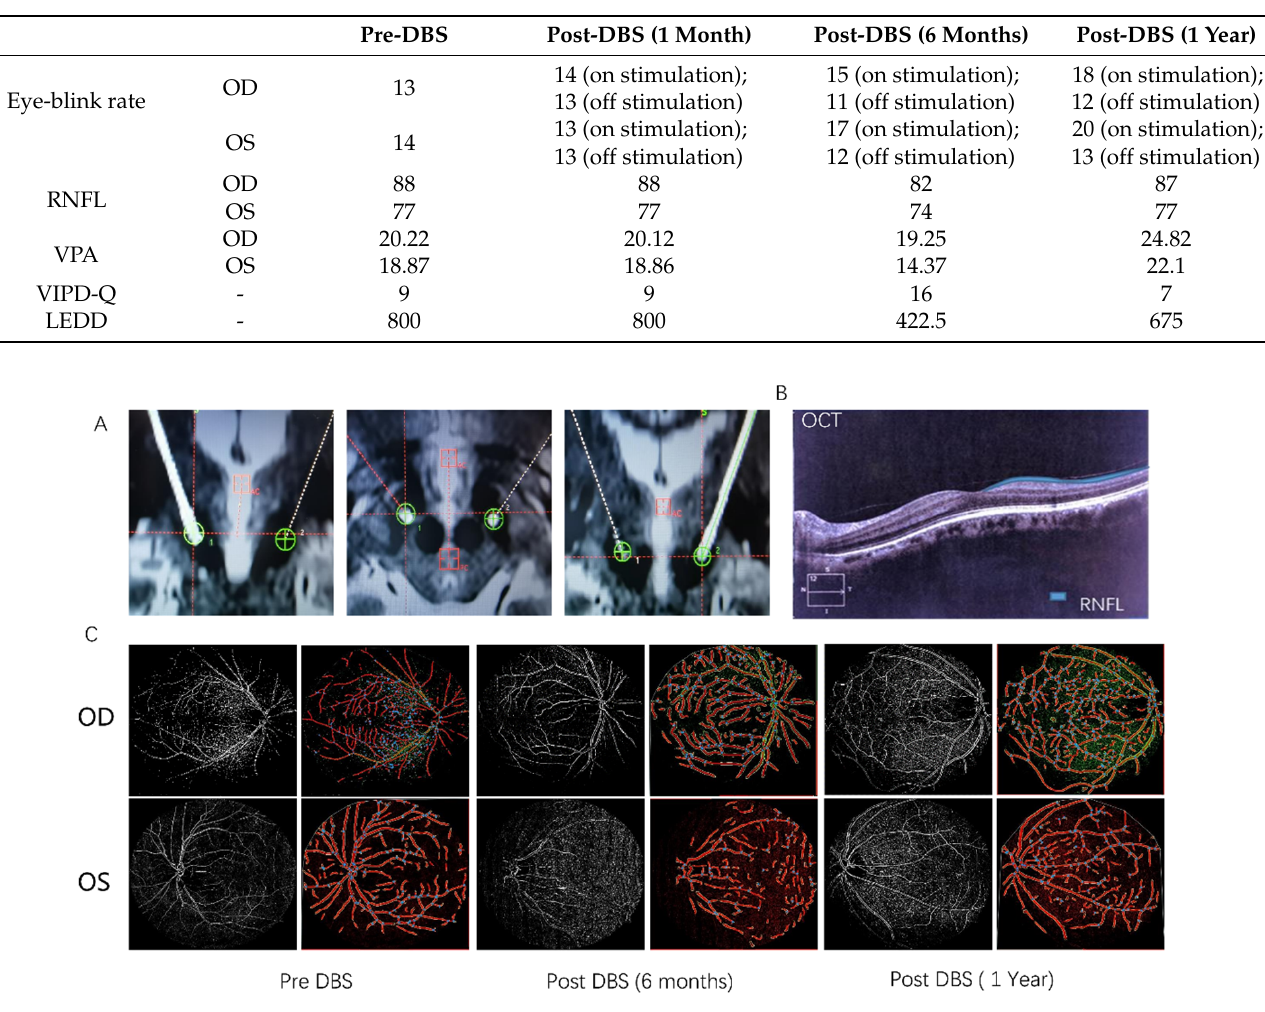
Figure 1. ( A ) The DBS contact locations. ( B ) The thickness of the patient’s retinal nerve fiber layer (RNFL) measured by OCT. ( C ) The vessel percentage areas of the patient before and after subthalamic nucleus deep brain stimulation (STN ‐ DBS). Table 1. Patient’s visual symptom severity pre ‐ and post ‐ STN ‐ DBS.